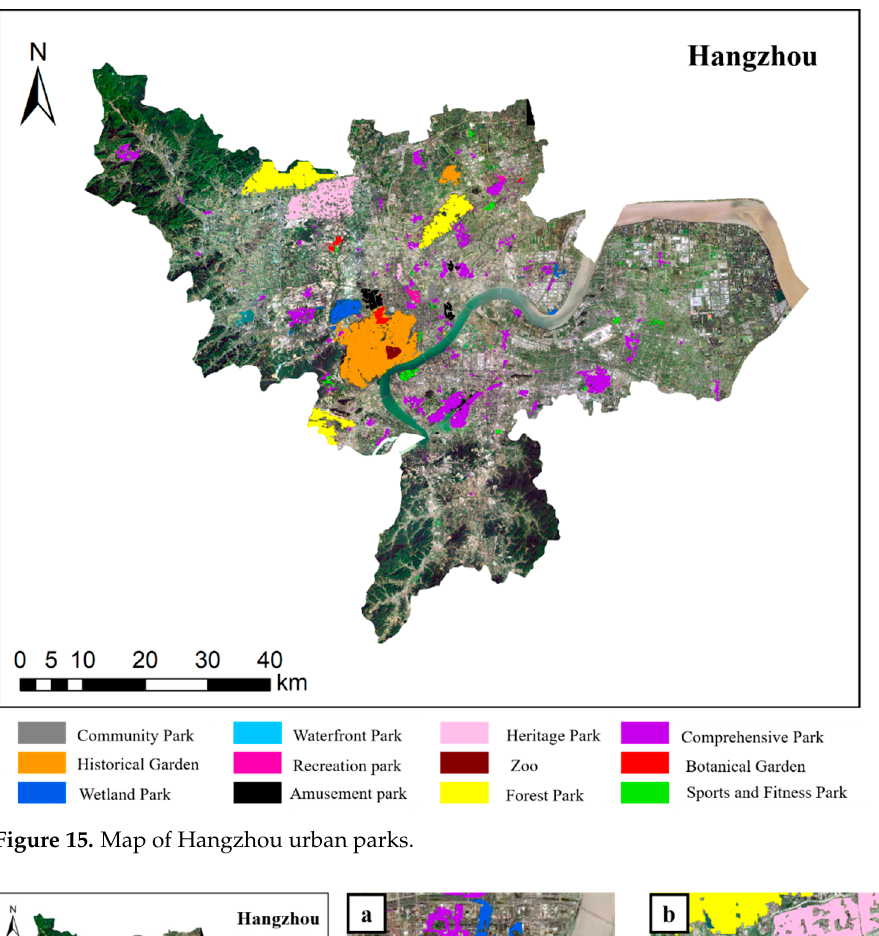
Figure 15. Map of Hangzhou urban parks.